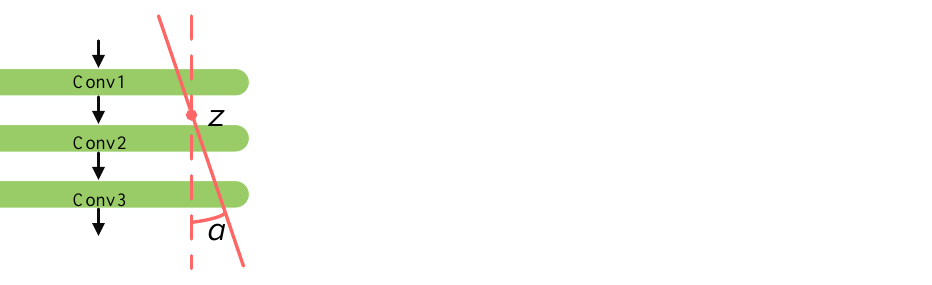
Figure 3. Illustration of the pruning ratio adjustment method based on the characteristics of remote sensing